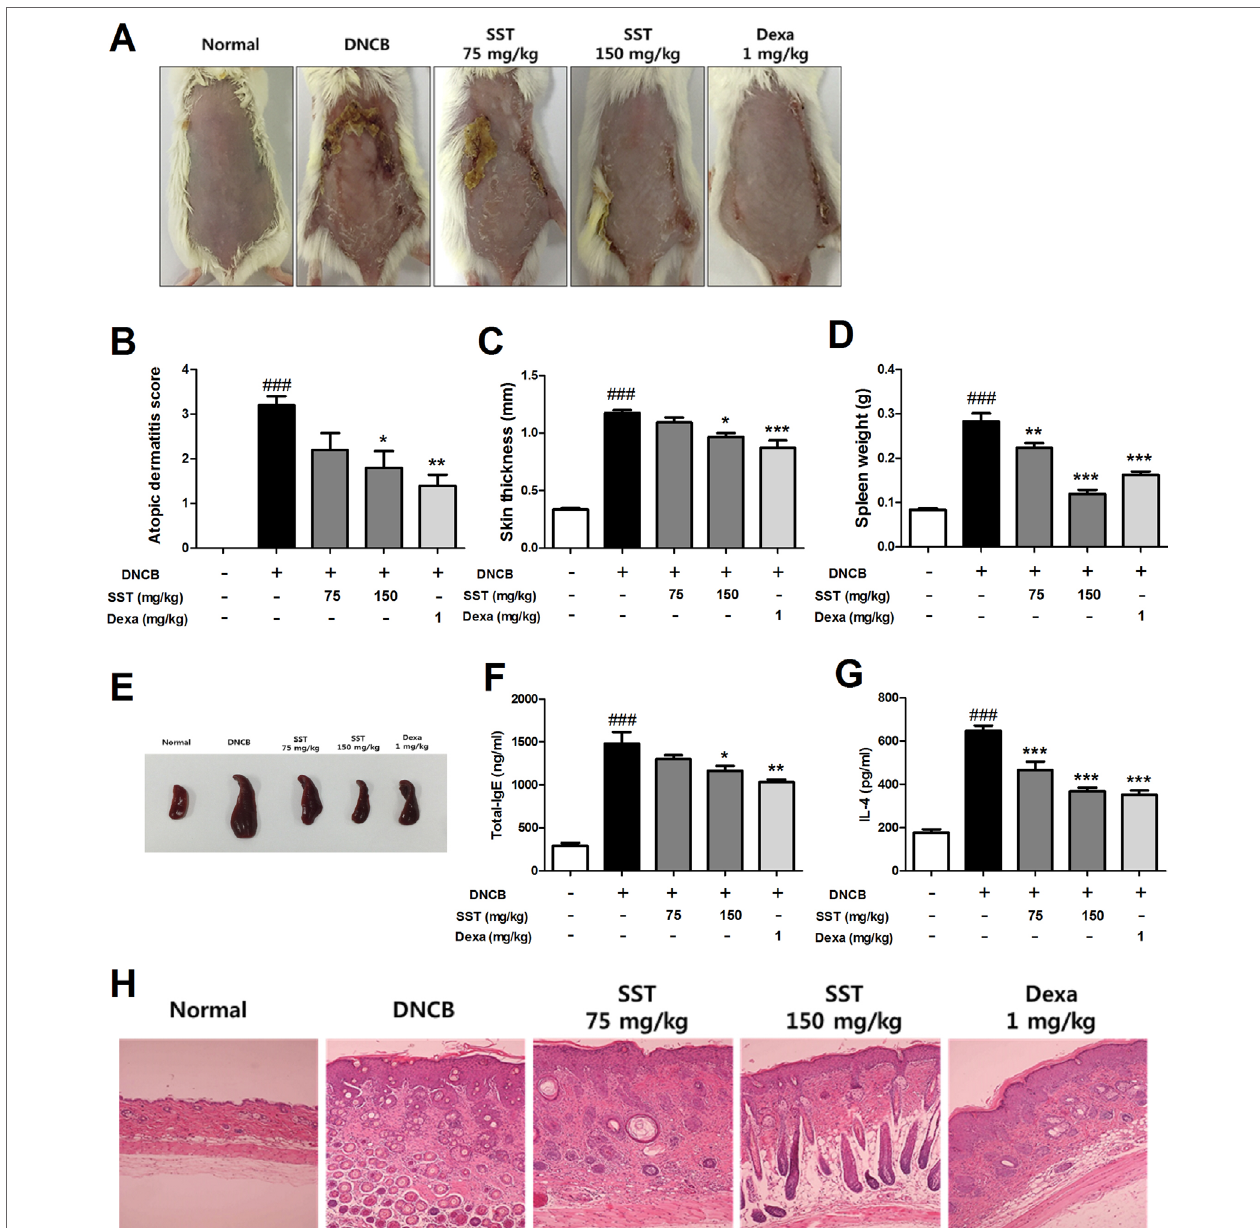
FIGURE 7 | Effects of SST on atopic dermatitis (AD)-like clinical signs in 2,4-Dinitrochlorobenzene (DNCB)-treated mice. To examine the severity of the AD-like lesions, photographs of mouse hairless dorsal skin were taken before mice were sacrificed on the 18th day of the experiment (A) . The clinical severity score of all mouse dorsal skin lesions was assessed according to the standard evaluation criteria (B) . Dorsal skin thickness of each mouse was measured three times in micrometer (C) . The spleen weights of six mice per group were measured electronically (D) , and pictures were taken to aid visual comparisons (E) . Serum levels of total IgE (F) and serum IL-4 (G) were measured by enzyme-linked immunosorbent assay (ELISA). The cut dorsal skin was fixed in 10%, cut into 6 μ m sections, and stained with hematoxylin and eosin (H&E). Photographs of each group represent images of all mice ( n = 6). Images were taken at 100× magnification (H) . ### p < 0.001 vs. Normal group, *p < 0.05, **p < 0.01, or ***p < 0.001 vs. DNCB-induced